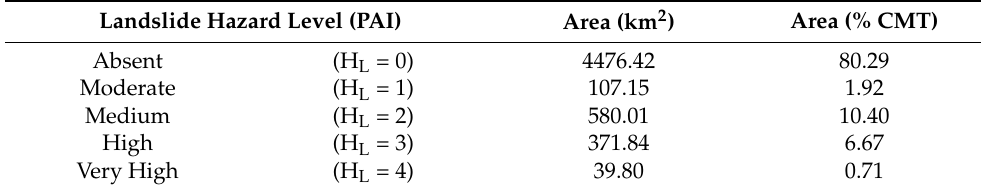
Table 3. Landslide hazard levels in the Coghinas-Mannu-Temo (CMT) subdistrict. Landslide Hazard Level